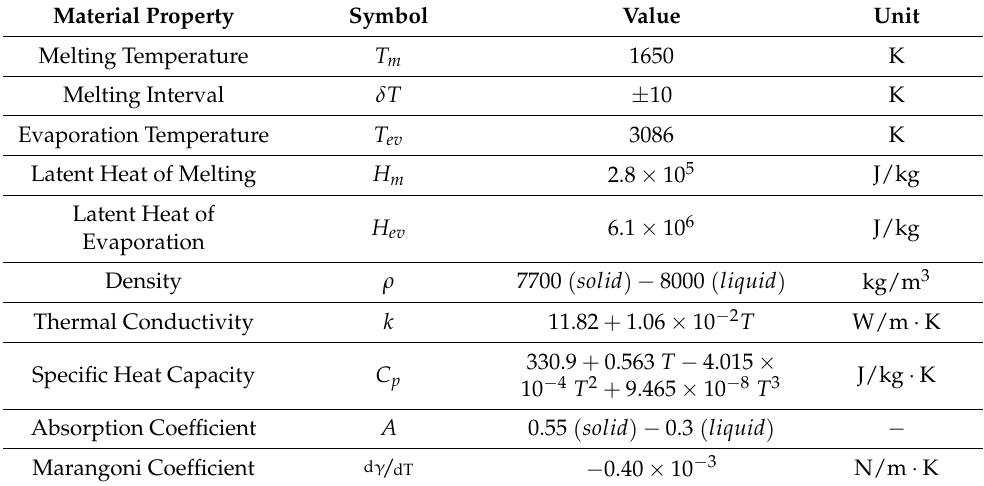
Table 2. Material properties of stainless steel 316L [31–33].